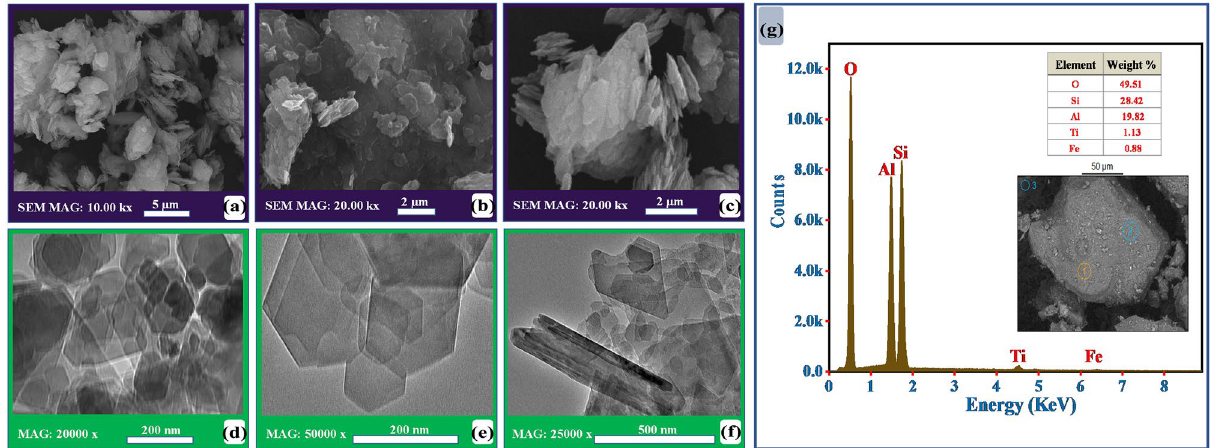
Figure 4. Shows the morphological analysis of the studied clay sample: ( a–c ) SEM micrographs, ( d–f ) TEM images at different magnifications, and ( g ) EDX first endothermic peak at this temperature was found to be 2.1%. With increasing the temperature, the second endothermic peak was detected at a temperature range from 310 to 350 °C. The endothermic peak at this tem- (Fig. 3d). The appearance of this large peak could be attributed to the dehydroxylation of structural OH from the kaolinite. More specifically, this dehydroxylation happened through restructuring the octahedral layer of